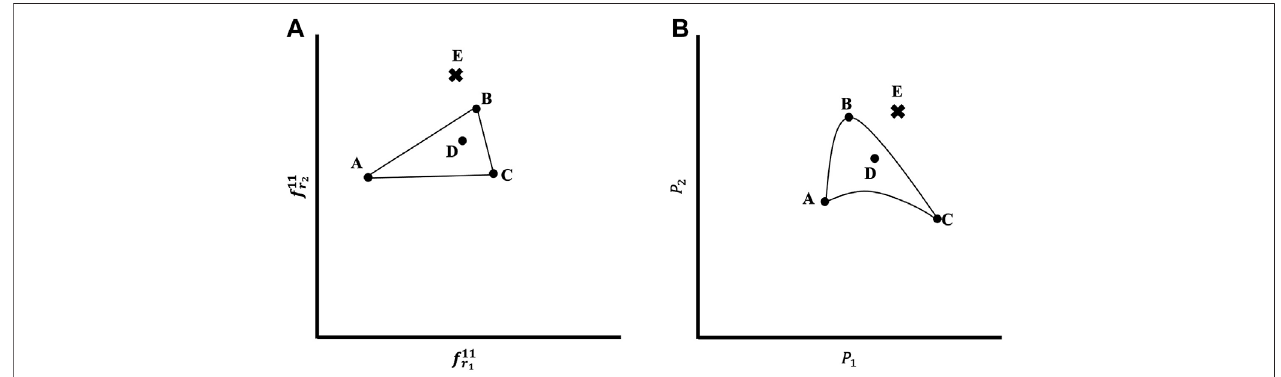
FIGURE 4 | (A) Schematic illustration of the generation of new microstructures (de fi ned in terms of 2-point spatial correlations) as interpolations or extrapolations. (B) Schematic depiction of the non-linear mapping of microstructures to the property space using a CNN model developed in this